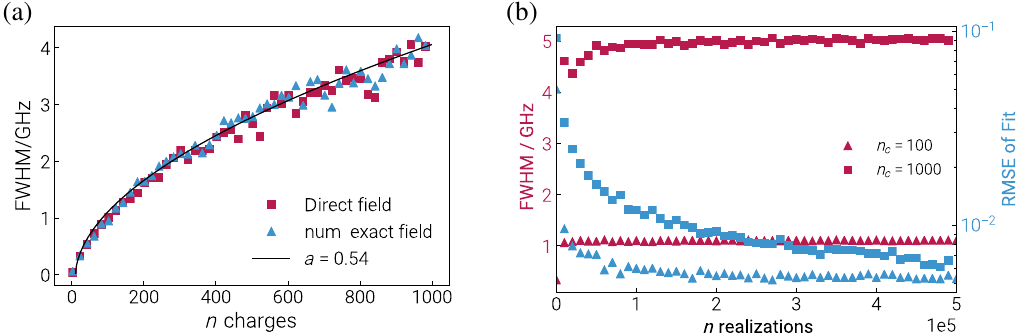
FIG. 10. Inhomogeneous broadening. (a) Inhomogeneous broadening caused by random distribution of charges with a density of 1 ppm (approx. 13800) in a cylindrical volume with a height of 1600 nm and a radius of 125 nm. The blue triangles are calculated using ˜ E the electric field, including the contribution produced by the polarization surface charge [ in Eq. (G9)]. The red squares show the result of only including the direct field. The black line represents a fit with the power law f ð x Þ ¼ b ð x − x 0 Þ a . (b) Blue triangles (100 charges) and squares (1000 charges) mark the FWHM of the inhomogeneous line for two different charge densities depending on the number of realizations of distributing the charges among the charge traps. The red squares and triangles show the root-mean-square error (RMSE) of the fit and the spectrum. The error drops for a higher count of realizations and appears to be saturating, indicating that the resulting spectrum reaches its equilibrium value. We chose 1000 realizations for the Monte Carlo simulation in panel